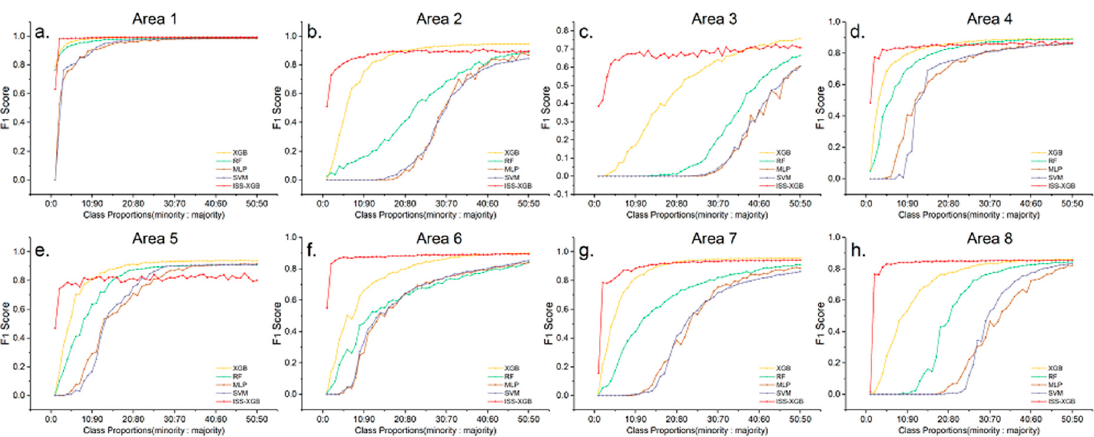
Figure 6. OA curves of all 8 areas for different imbalanced samples with ISS-XGB (red), XGB (yellow), RF (green), MLP (brown), and SVM (purple). Sub-figure ( a ~ h ) shows the OA curves by different areas (( a ): Area 1; ( b ): Area 2; ( c ): Area 3; ( d ): Area 4; ( e ): Area 5; ( f ): Area 6; ( g ): Area 7; ( h ): Area 8).